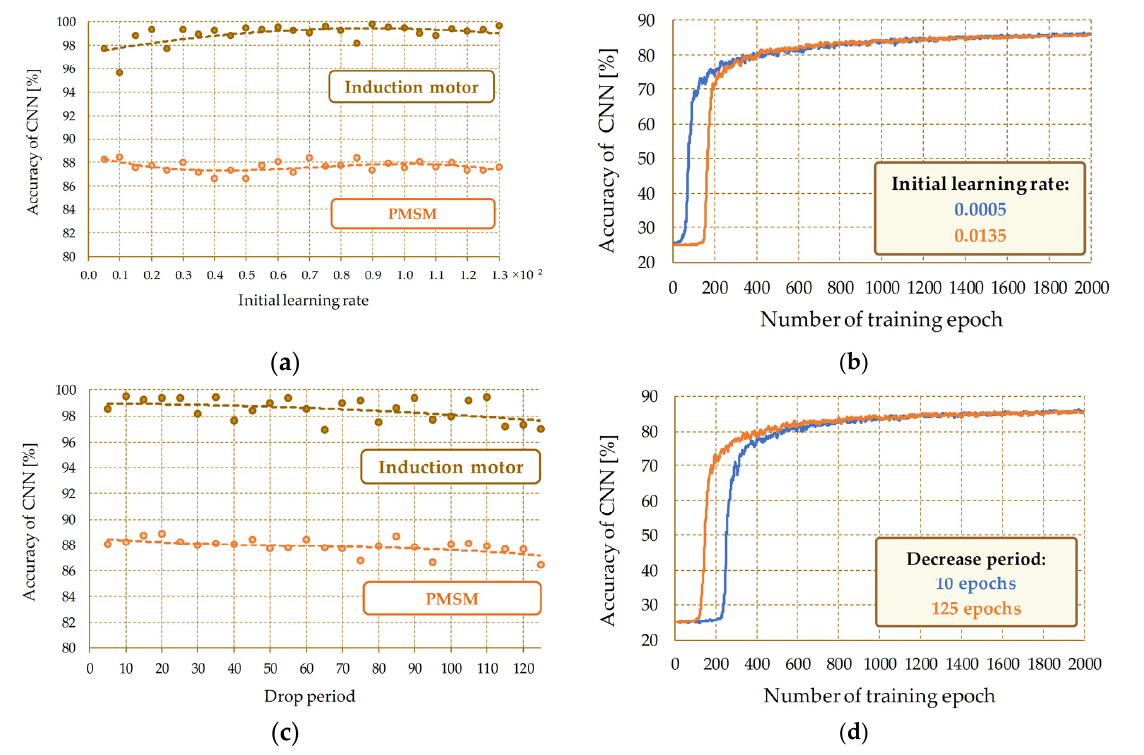
Figure 13. Influence of CNN training process parameters on the precision of the diagnostic system: ( a ) change of the initial value of the learning constant; ( b ) the course of learning curves during changes of the learning constant—PMSM motor; ( c ) changing the period of decline of the learning constant; ( d ) the course of learning curves during changes of the learning constant decrease